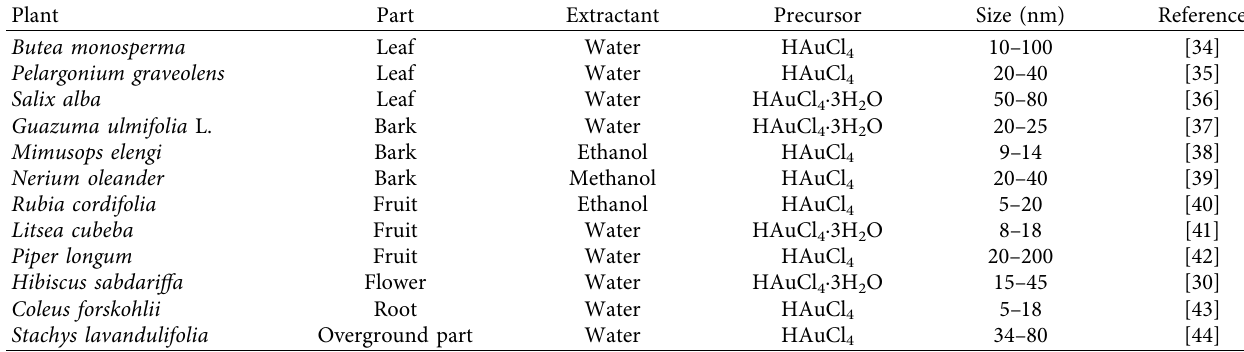
Table 1: Representative examples for the use of plant extracts for AuNP